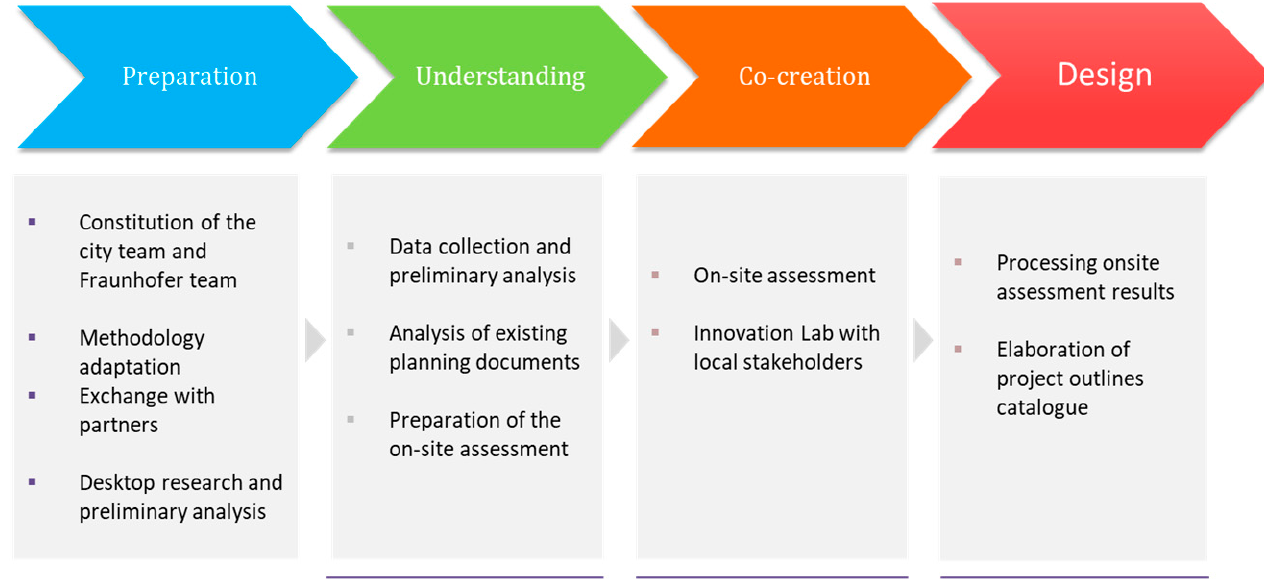
Figure 2. The 4 step City Lab process in SPARCS.